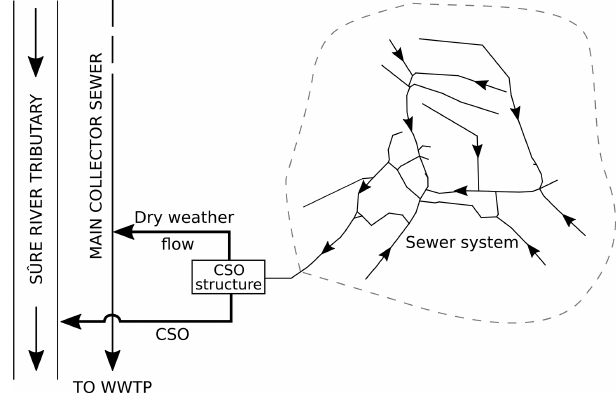
Figure 1. Scheme of the sewer system analysed. Adapted from Andrés-Doménech et al.